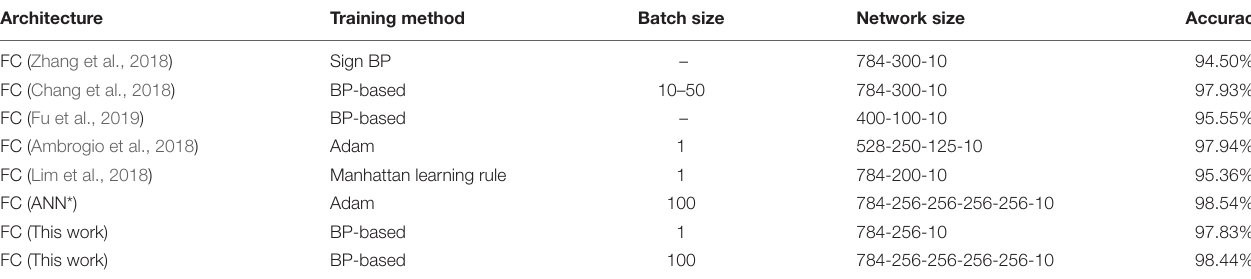
FIGURE 6 | Training curves of the proposed on-chip training scheme depending on (A) the total time step ( T ) in FP, (B) the width of the hidden layer, and (C) the number of hidden layers. (D) Training curves when modulating λ at epoch 11. Deep networks show variance over epochs with large λ , but modulating λ stabilizes the training curve and improves the accuracy of the network. TABLE 2 | Comparison of the proposed with conventional on-chip training schemes for hardware-based neural networks using analog synaptic devices.